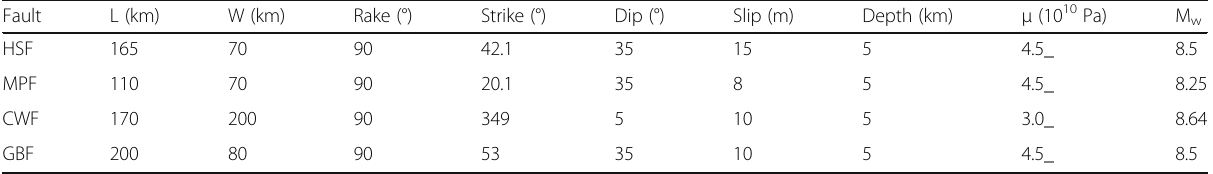
Table 1 Fault parameters of the tsunamigenic sources considered in this study. These parameters have been used for the three different tides MHHW, MSL, and MLLW Fault L (km) W